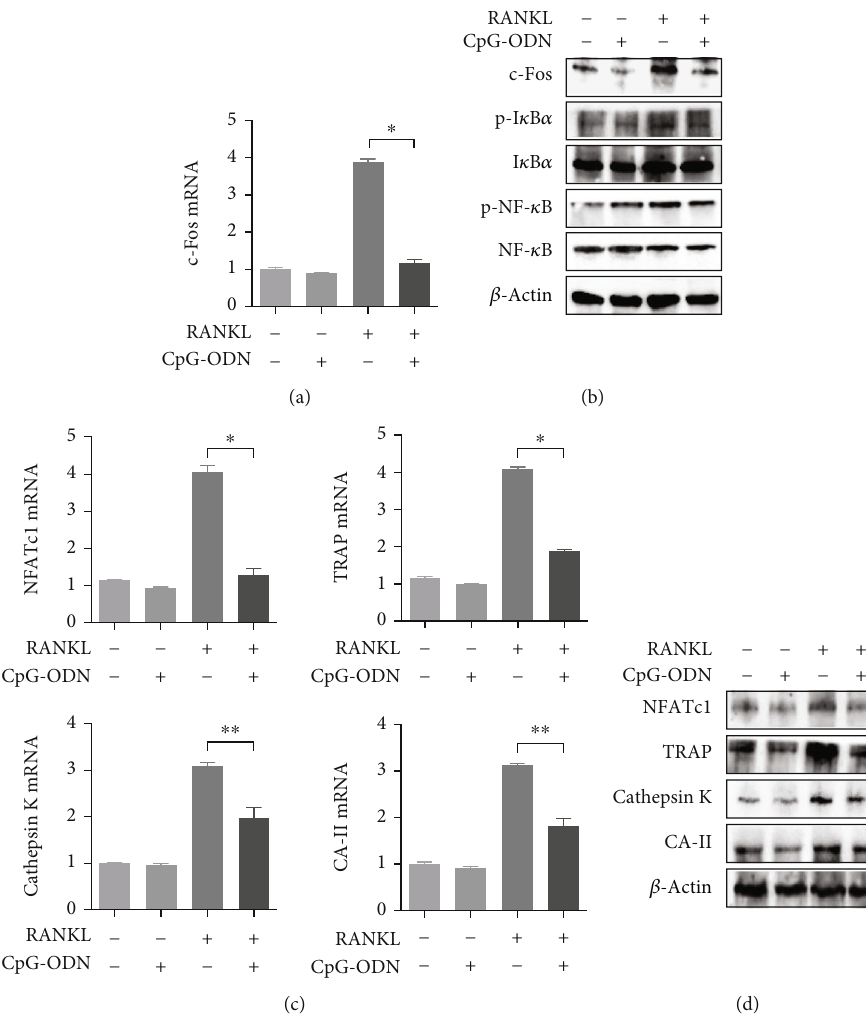
Figure 1: The inhibitory e ff ect of CpG-ODN on osteoclastogenic molecules. (a) c-Fos mRNA expression in RAW 264.7 cells stimulated with either RANKL (100ng/ml) for 6 days or CpG-ODN (1 μ M) for 4 days and both. (b) c-Fos, p-I κ B α , and p-NF- κ B protein expressions in RAW 264.7 cells stimulated with either RANKL or CpG-ODN and both. (c, d) mRNA and protein expression of osteoclast-speci fi c molecules such as NFATc1, TRAP, cathepsin K, and CA-II in RAW 264.7 cells incubated with either RANKL or CpG-ODN and both. Abbreviation: NFATc1: nuclear factor of activated T cells c1; TRAP: tartrate-resistant acid phosphatase; CA-II: carbonic anhydrase-II. Error bars represent standard deviation of the measurement of three separate samples ( ∗ p < 0 : 001 and ∗∗ p < 0 : 05